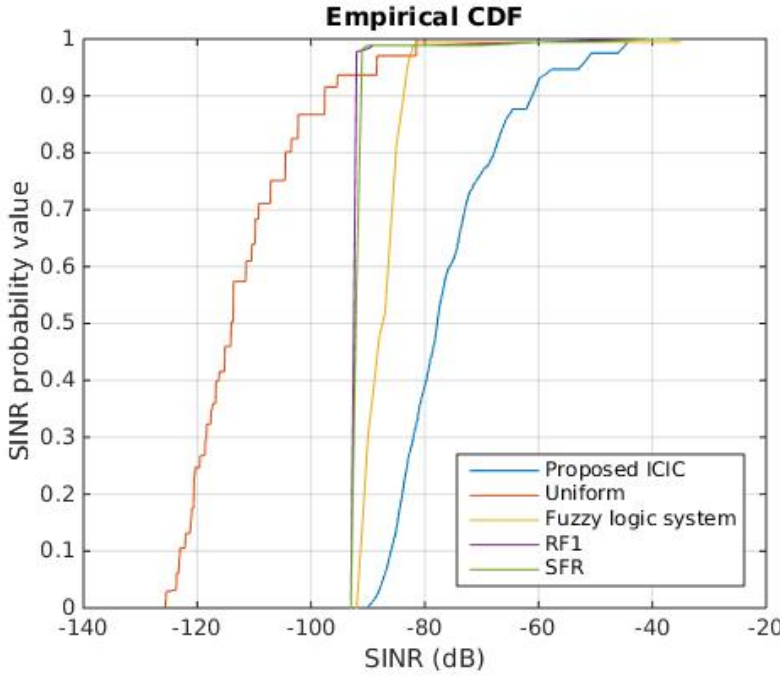
Figure 11. Cumulative Distribution function of SINR. Proposed ICIC scheme was clearly